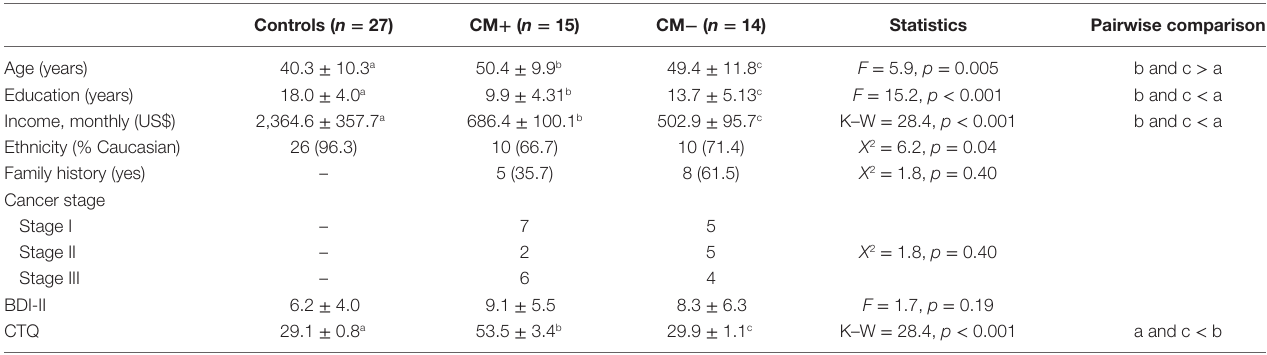
TaBle 1 | Demographic and clinical data of studied groups.